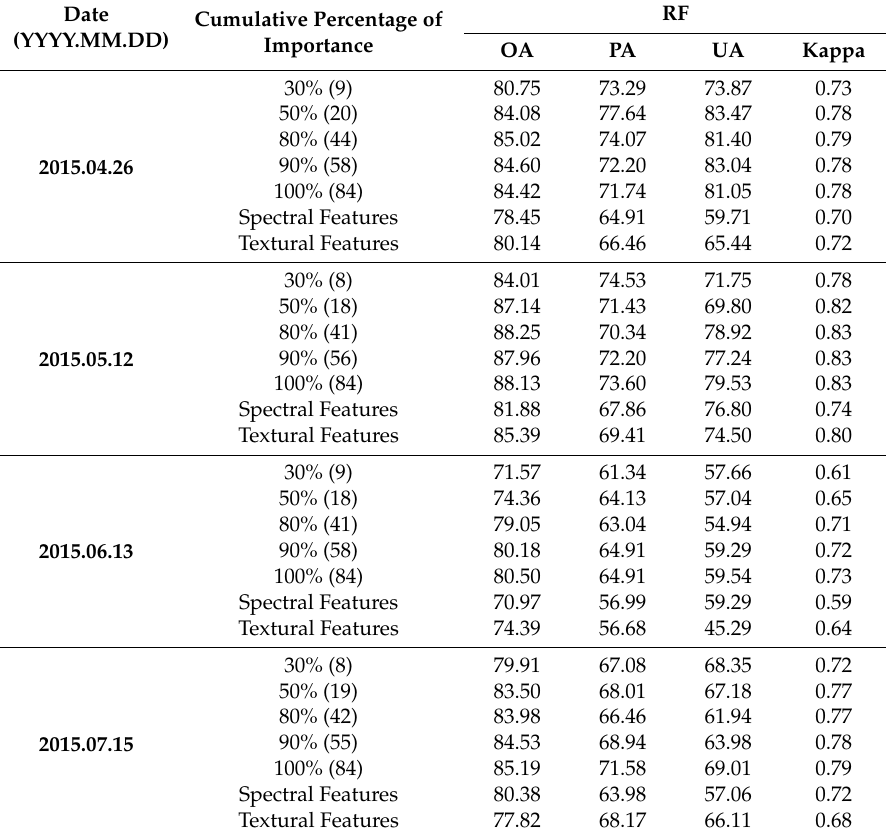
Table 10. The mapping accuracies generated from RF using different features in